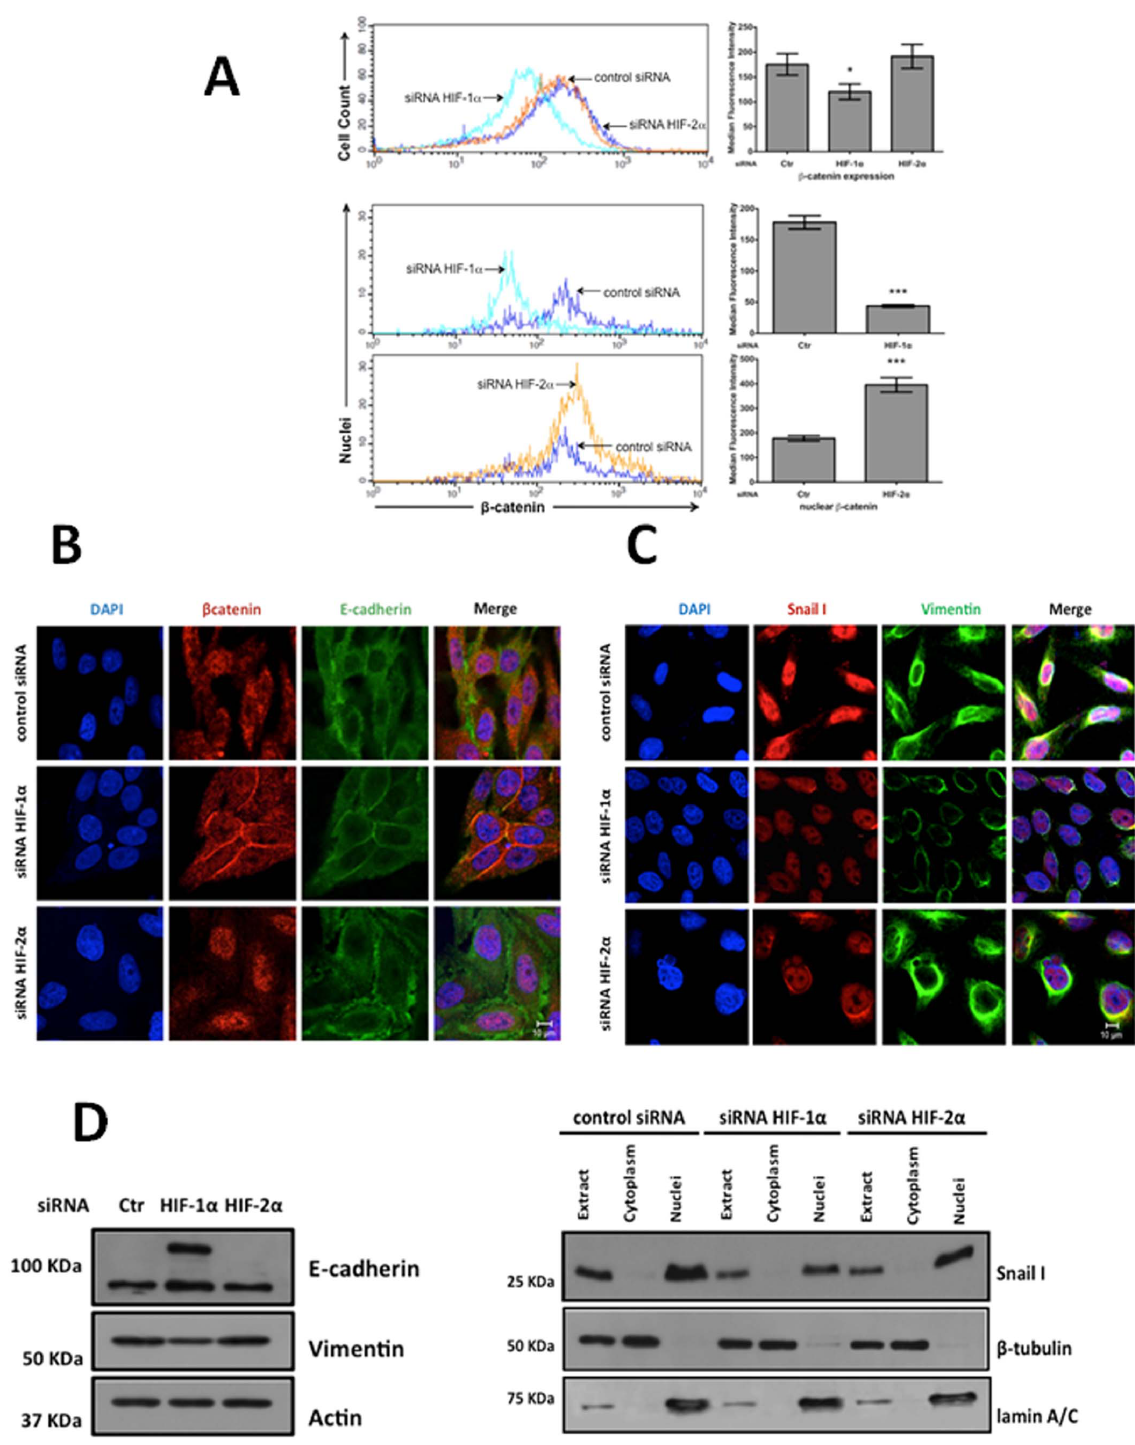
Figure 8. Stable knockdown of HIF-1 a in SW480 cells results in decreased b -catenin expression levels and co-localization of b - catenin with E-cadherin at the cell membrane. A) Upper panel: Decreased b -catenin expression in HIF-1 a -knockdown SW480 cells. The cells were incubated in the presence of EDTA, washed, and incubated with mouse anti- b -catenin antibody. The cells were washed and stained with goat Alexa647-conjugated anti-mouse secondary antibody and examined by flow cytometry. Controls stained with only the secondary antibody were prepared and were used as controls (not shown). The figure shows the overlapping histograms of the labeled SW480 control cells (blue line and Ctr in the bar graph), HIF-1 a -silenced cells (green line), and HIF-2 a -knockdown cells (orange line). The bar graph on the right shows the means of the median fluorescence intensity 6 SEM from at least four independent experiments. *: p , 0.05. Middle panel: Quantification of b -catenin in nuclei isolated from SW480 control (scrambled shRNA) or HIF-1 a -depleted cells. Lower panel: Quantification of b -catenin in nuclei isolated from SW480 control (scrambled shRNA) or HIF-2 a -depleted cells. The nuclei were purified and labeled with anti- b -catenin and with Alexa 647-conjugated goat anti-mouse antibody in staining buffer as described in the ‘‘Materials and Methods’’. After the final wash, the nuclei were fixed and analyzed by flow